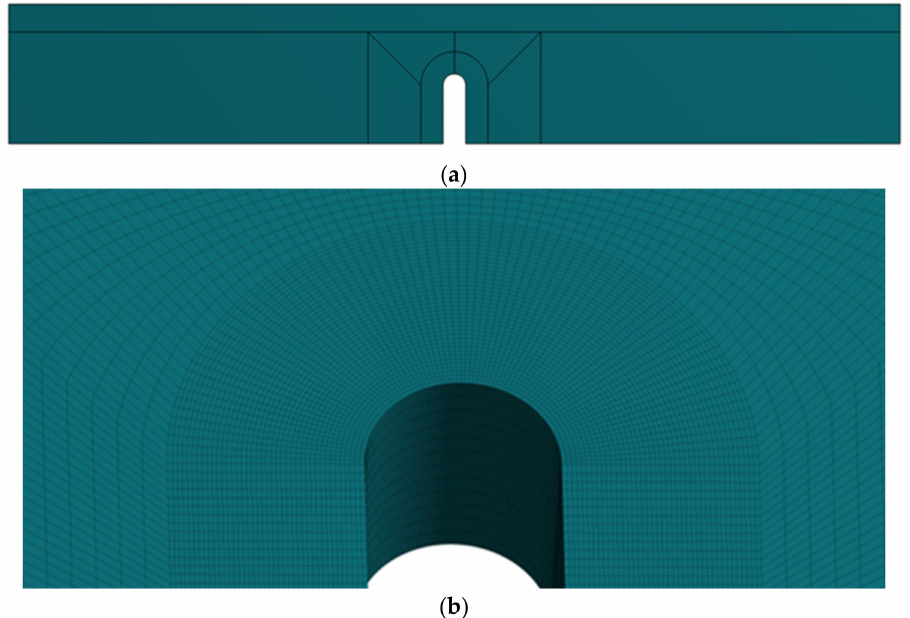
Figure 4. ( a ) Structured mesh used for the 3D model; ( b ) detail of the mesh near the notch